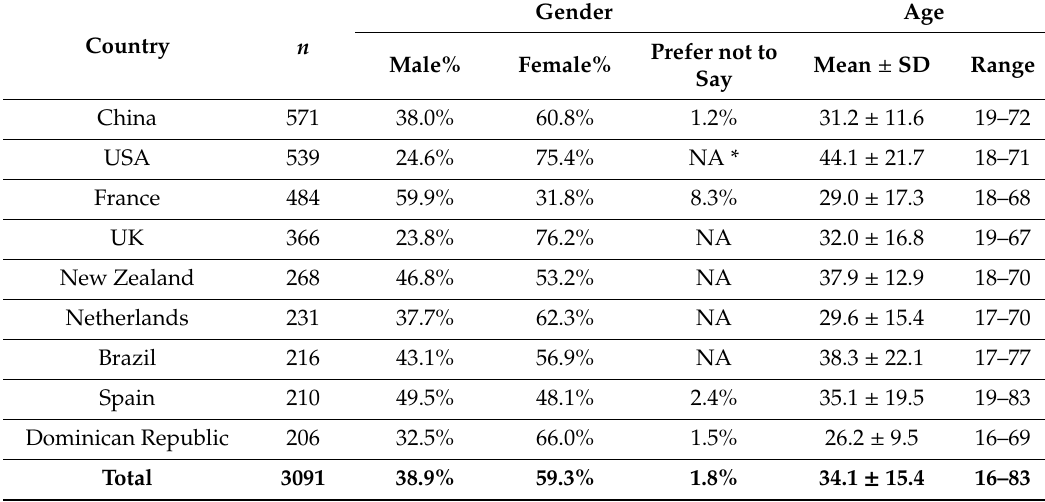
Table 1. Demographics (gender and age) of the survey respondents per